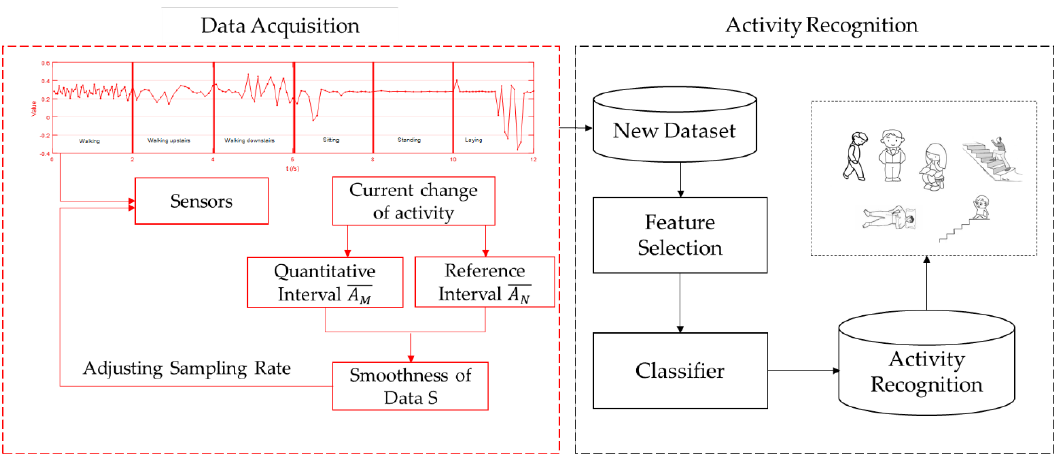
Figure 1. Energy-efficient activity recognition system. Figure 1. Energy-e ffi cient activity recognition